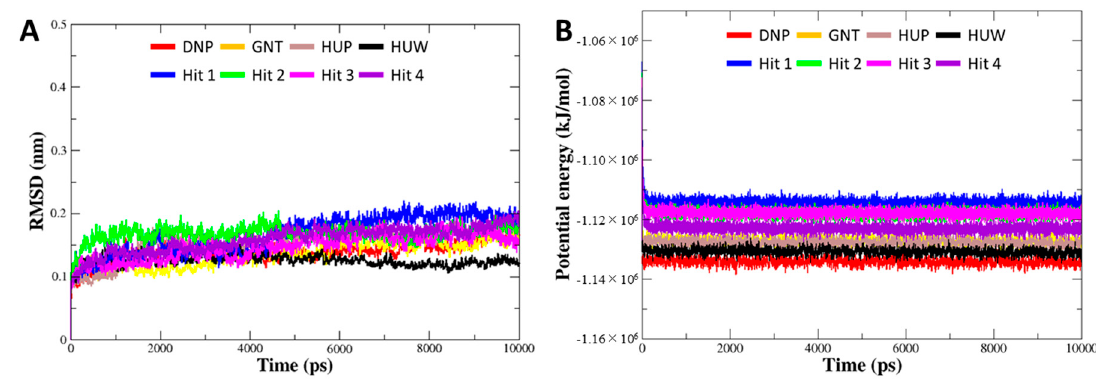
Figure 6. Overall stability of MD trajectory of each system. ( A ) Root mean square deviation (RMSD) and ( B ) potential energy for the system were calculated during 10 ns simulation time.